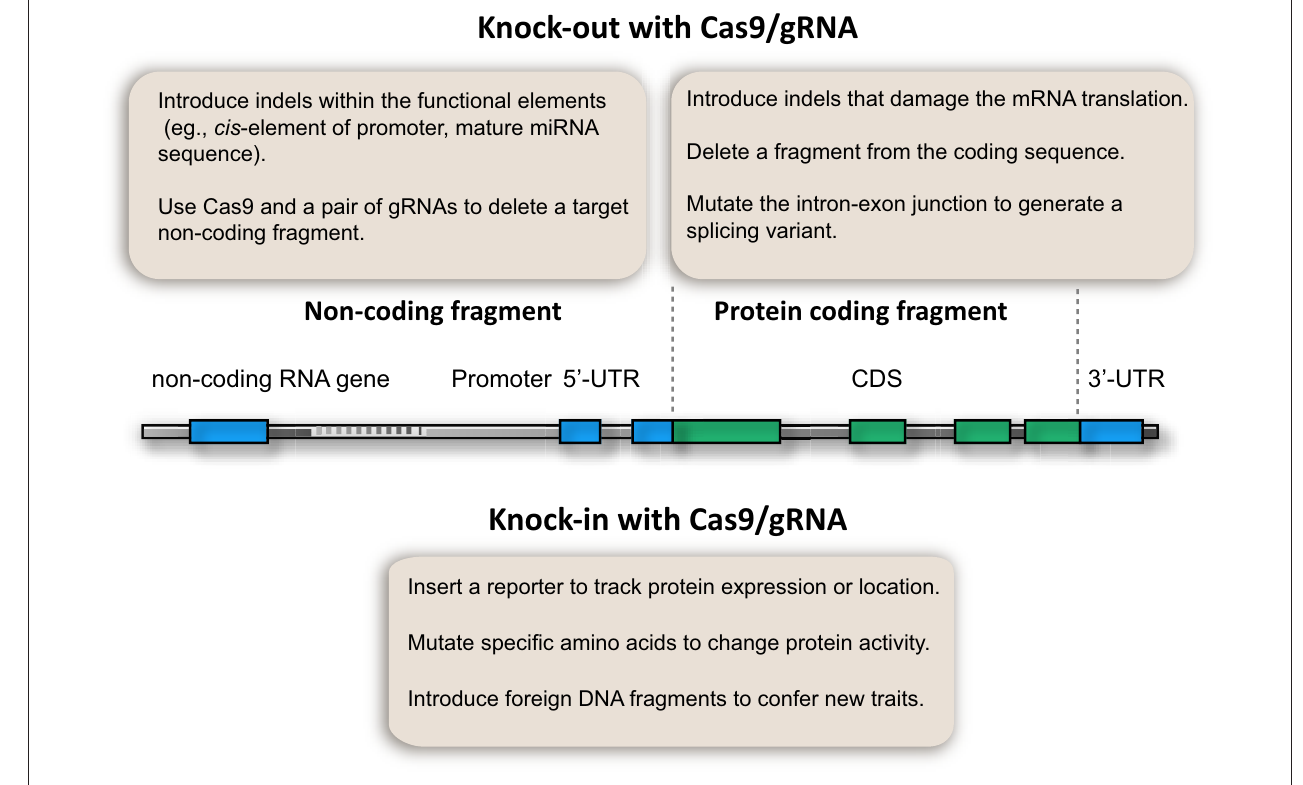
FIGURE 2 | Potential applications of CRISPR/Cas9 genome editing in plant genetic analysis.